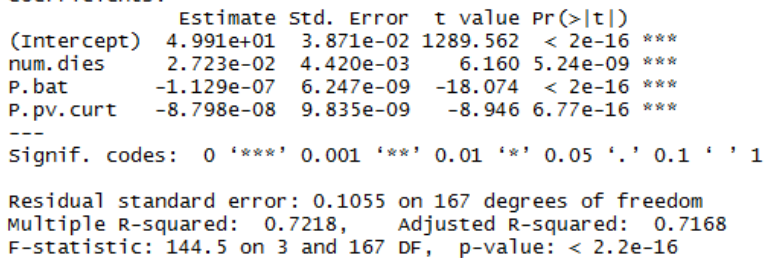
Figure 5. Linear regression results for the coefficients of the minimum frequency equation. Caption from R